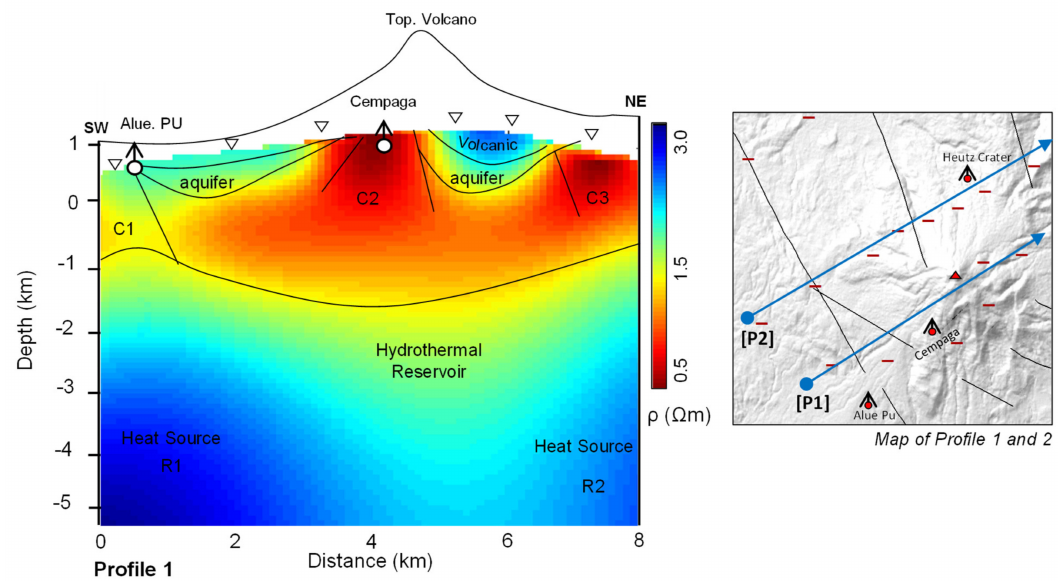
Figure 8. Resistivity model was obtained from the 2D inversion of Profile 1, which crosses the Cempaga crater. To the right is a map showing the crossing area from both profiles. Conductive areas were identified at several locations that intersect with manifestations and